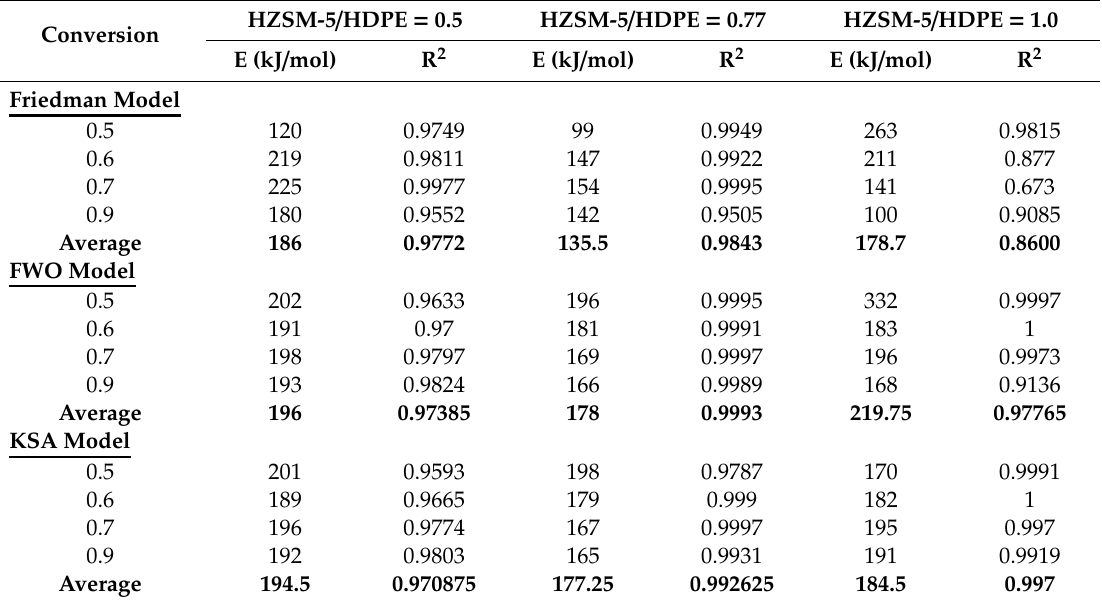
Table 6. Activation energies calculated by isoconversional